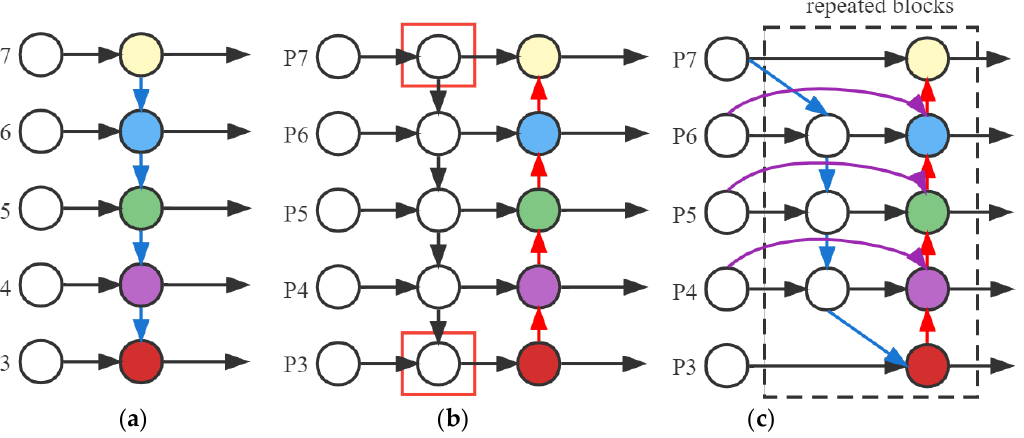
Figure 5. FPN, PANet, and BiFPN structure. ( a ) The structure of FPN, ( b ) The structure of PANet, ( c ) The structure of BiFPN.